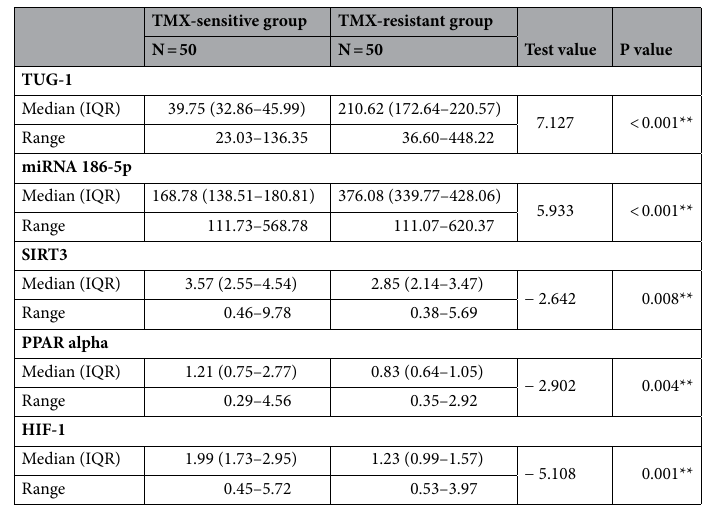
Table 1. Comparison between TMX sensitive and TMX resistant groups regarding the different studied parameters. P value > 0.05: non significant; P value < 0.05: significant*; P value < 0.01: highly significant**. ≠ Mann–Whitney test.